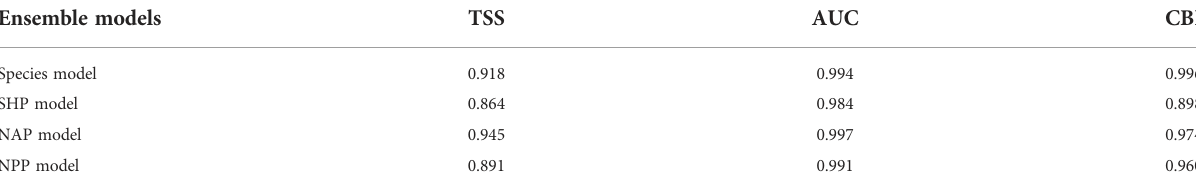
TABLE 5 Mean values of the true skill statistics (TSS), the area under the receiver operating characteristic curve (AUC) and the continuous Boyce index (CBI) for the ensemble models built at the species level (species model) and populations level (SHP model, NAP model and NPP model). Ensemble models